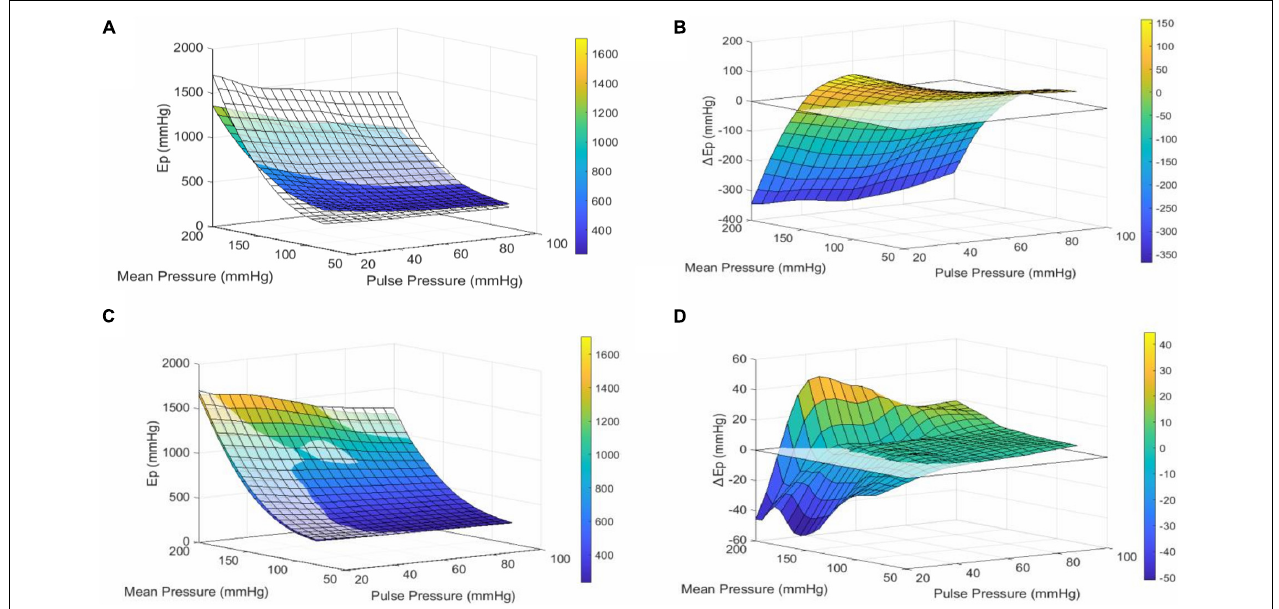
FIGURE 3 | Pulse Pressure alters VSMC reactivity. (A) Surface plot of the mean interpolated raw data. The transparent surface plot is the uncontracted, basal state of the aortic segment, while the colored surface plot shows the same segment in 50 mM KCl-induced contracted state. At low mean pressures (80–140 mmHg), contraction of VSMCs makes the segment stiffer, while at high mean pressures (140–200 mmHg), the vessel is less stiff when contracted. This effect is consistent for all pulse pressures. (B) Surface plot of the mean interpolated data of the difference in stiffness between contracted and uncontracted state (contracted–basal). (C) Surface plot of the mean interpolated raw data. The transparent surface plot is the uncontracted, basal state of the aortic segment while the colored surface plot shows the same segment treated with 2 µ M DEANO. (D) Surface plot of the mean interpolated data of the difference in stiffness (Ep) between relaxed and basal state (relaxed–basal). n = 7. Ep, Peterson’s modulus of elasticity; (cid:49) EP, EP contraction –EP uncontracted ; PP, pulse